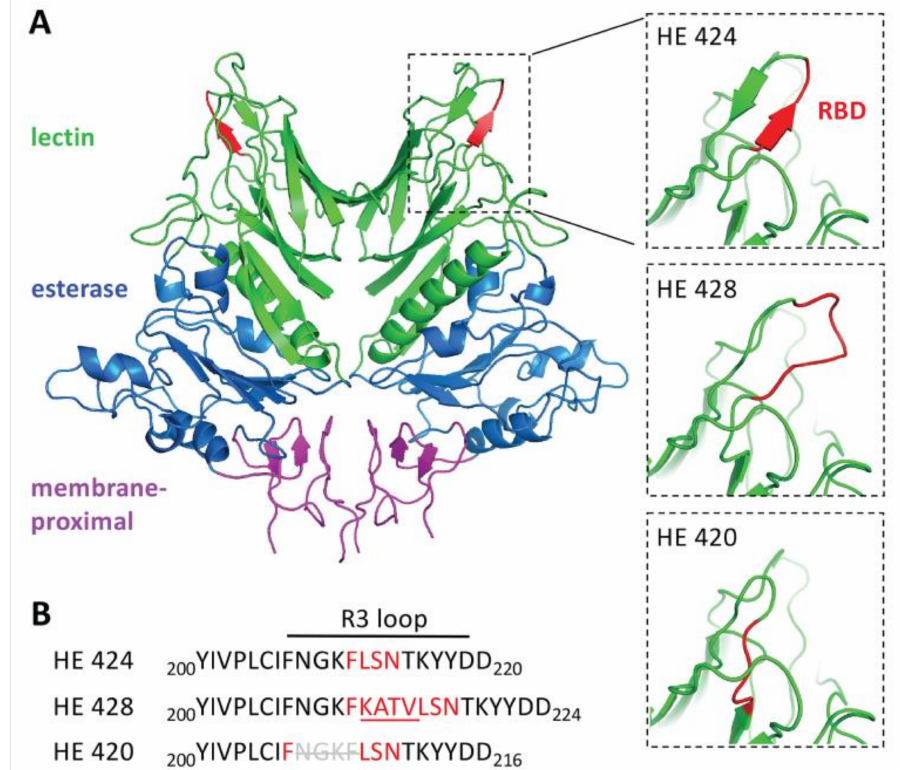
Figure 6. Structural modeling of HE gene length variants. Structural models of the homodimeric hemagglutinin-esterase protein (HE424) and mutants containing a 4-amino acid insertion (HE428) or deletion (HE420) in the receptor binding domain. A. Domains of HE424 were colored according to [28] with the lectin domain colored green, the esterase domain colored blue, and the membrane-proximal domain colored pink. The smaller panels zoom in on the R3 loop with the residues in the receptor binding domain (RBD) colored red. B. Sequences of the HE protein variants in the region containing the R3